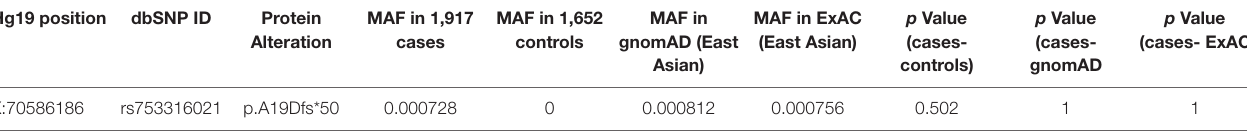
TABLE 2 | The frameshift variant in different databases.